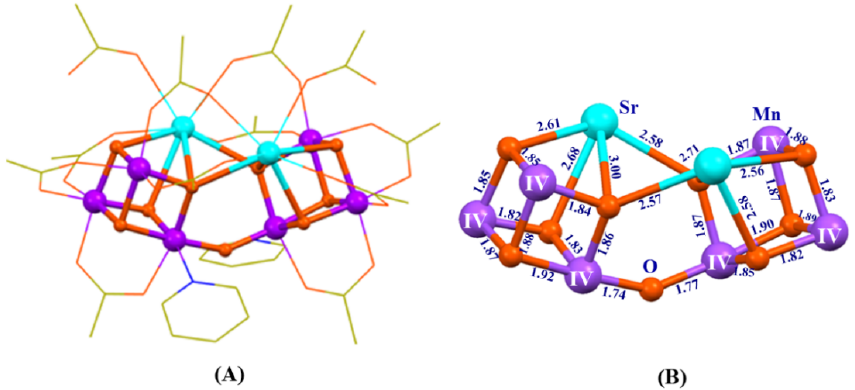
Figure 8. Structure of the Mn 6 Sr 2 O 9 -complex [113]. ( A ) Whole structure of the Mn 6 Sr 2 O 9 -complex. ( B ) Core structure of the Mn 6 Sr 2 O 9 -complex. Mn, Sr, O, N, and C are shown in purple, cyan, orange, blue, and yellow, respectively. For clarity, all the methyl groups and hydrogen atoms are not shown.